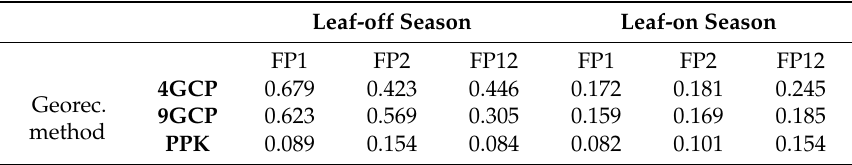
Table 8. Vertical root mean square errors (RMSE z ) for point positions acquired on digital elevation models (in